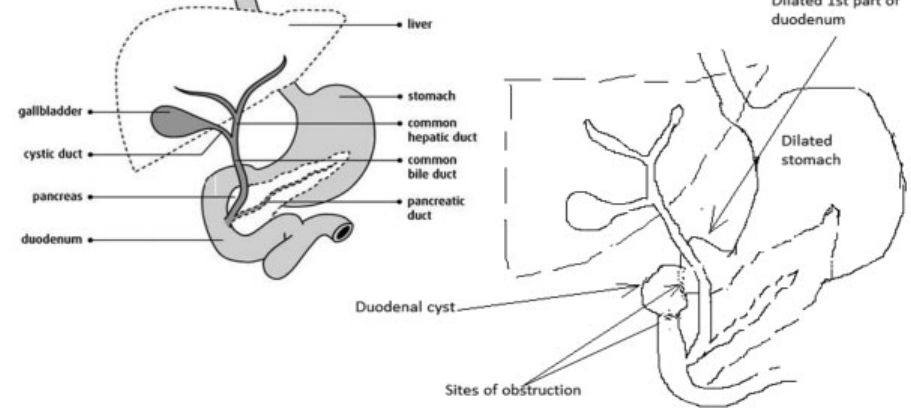
Fig. 3 Illustration showing the duodenal